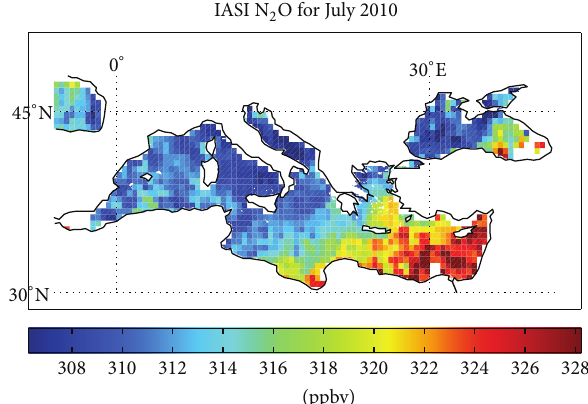
Figure 9: Retrieved tropospheric N 2 O content for the month of July 2010. Data have been smoothed and rendered on a grid of 0.5 ∘ × 0.5 ∘ (lat. × lon.).